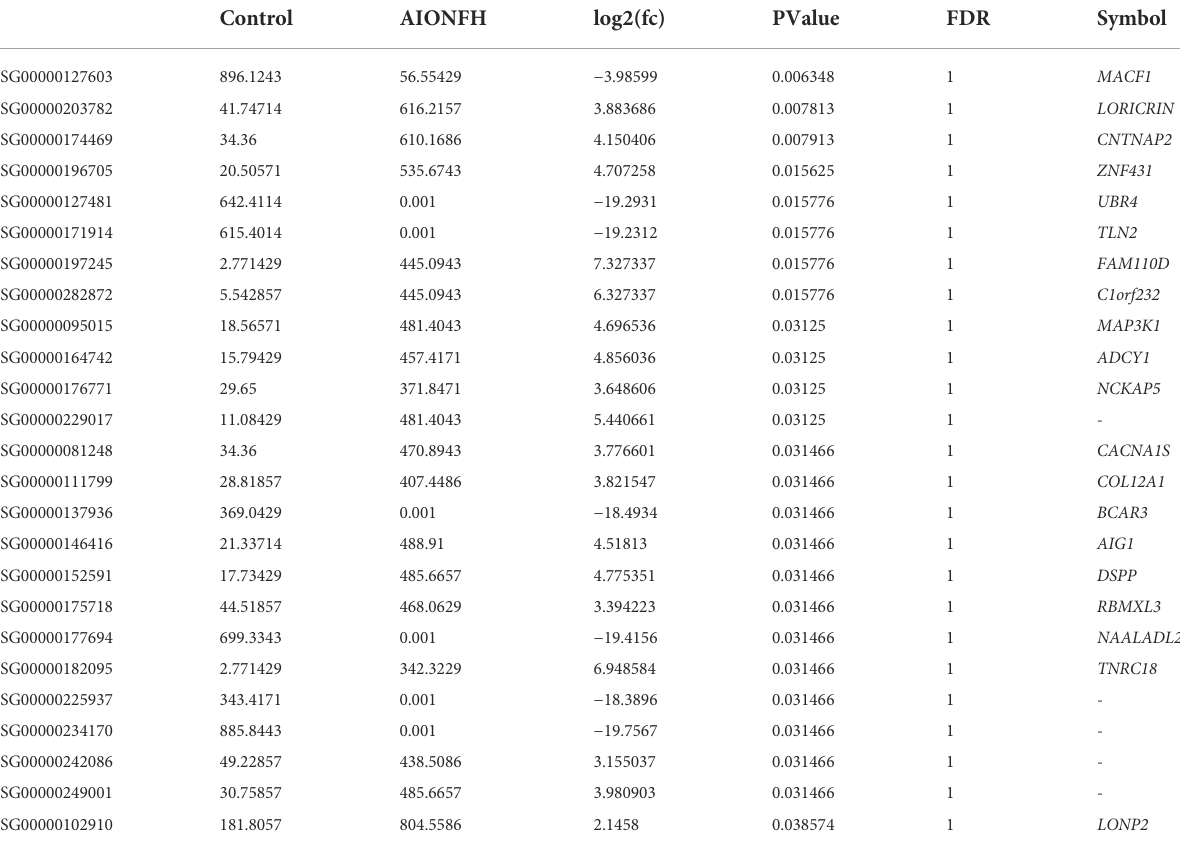
TABLE 1 Signi fi cant exon region genes of